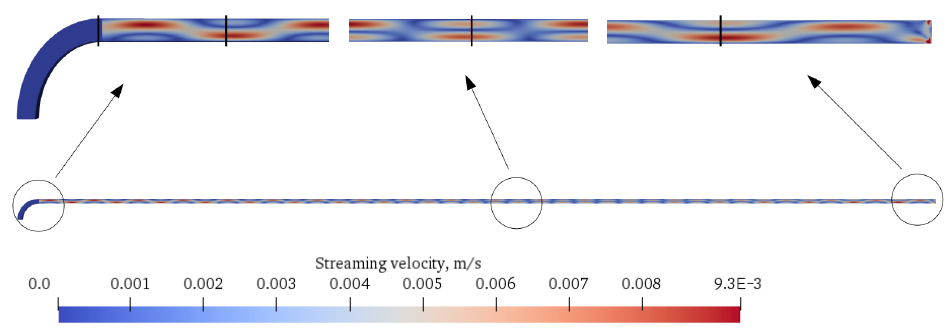
Figure 14. Streaming magnitude map of the upper half of the U-shaped